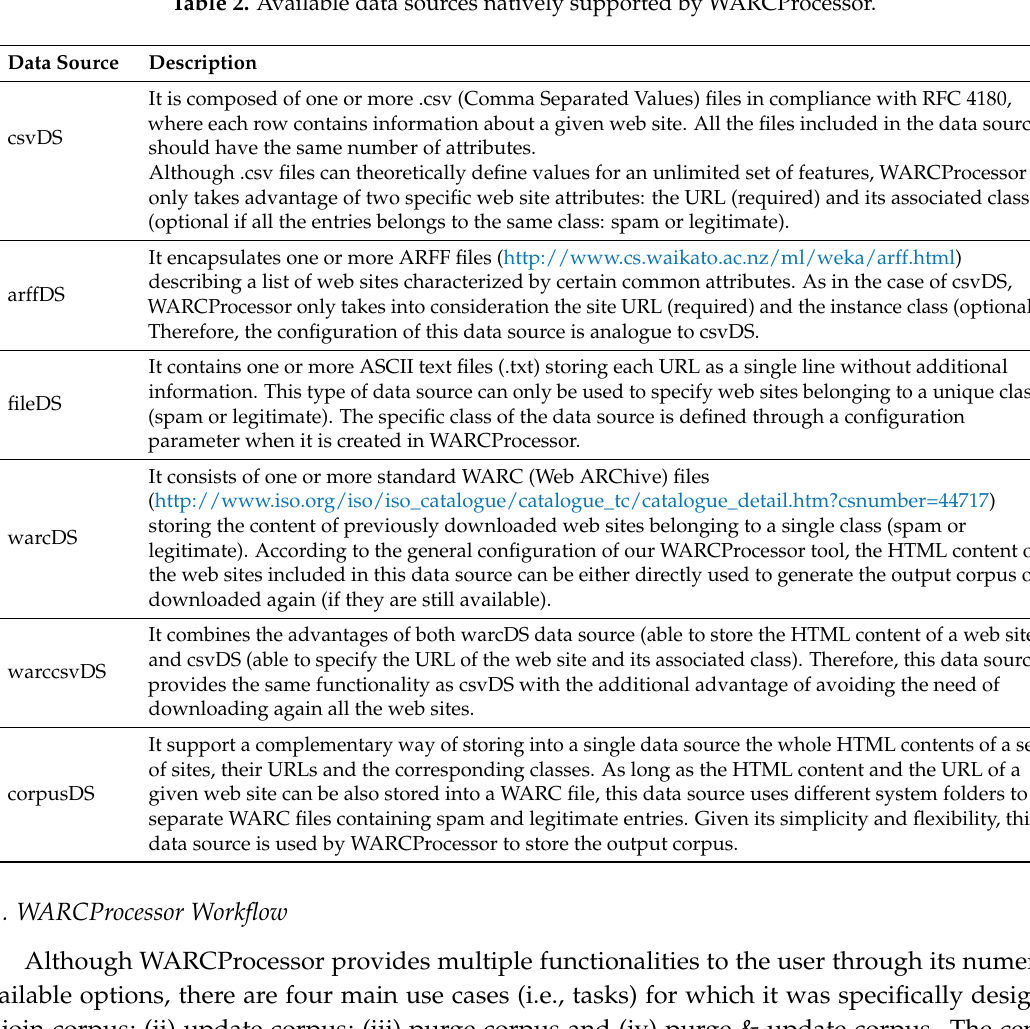
Table 2. Available data sources natively supported by WARCProcessor.